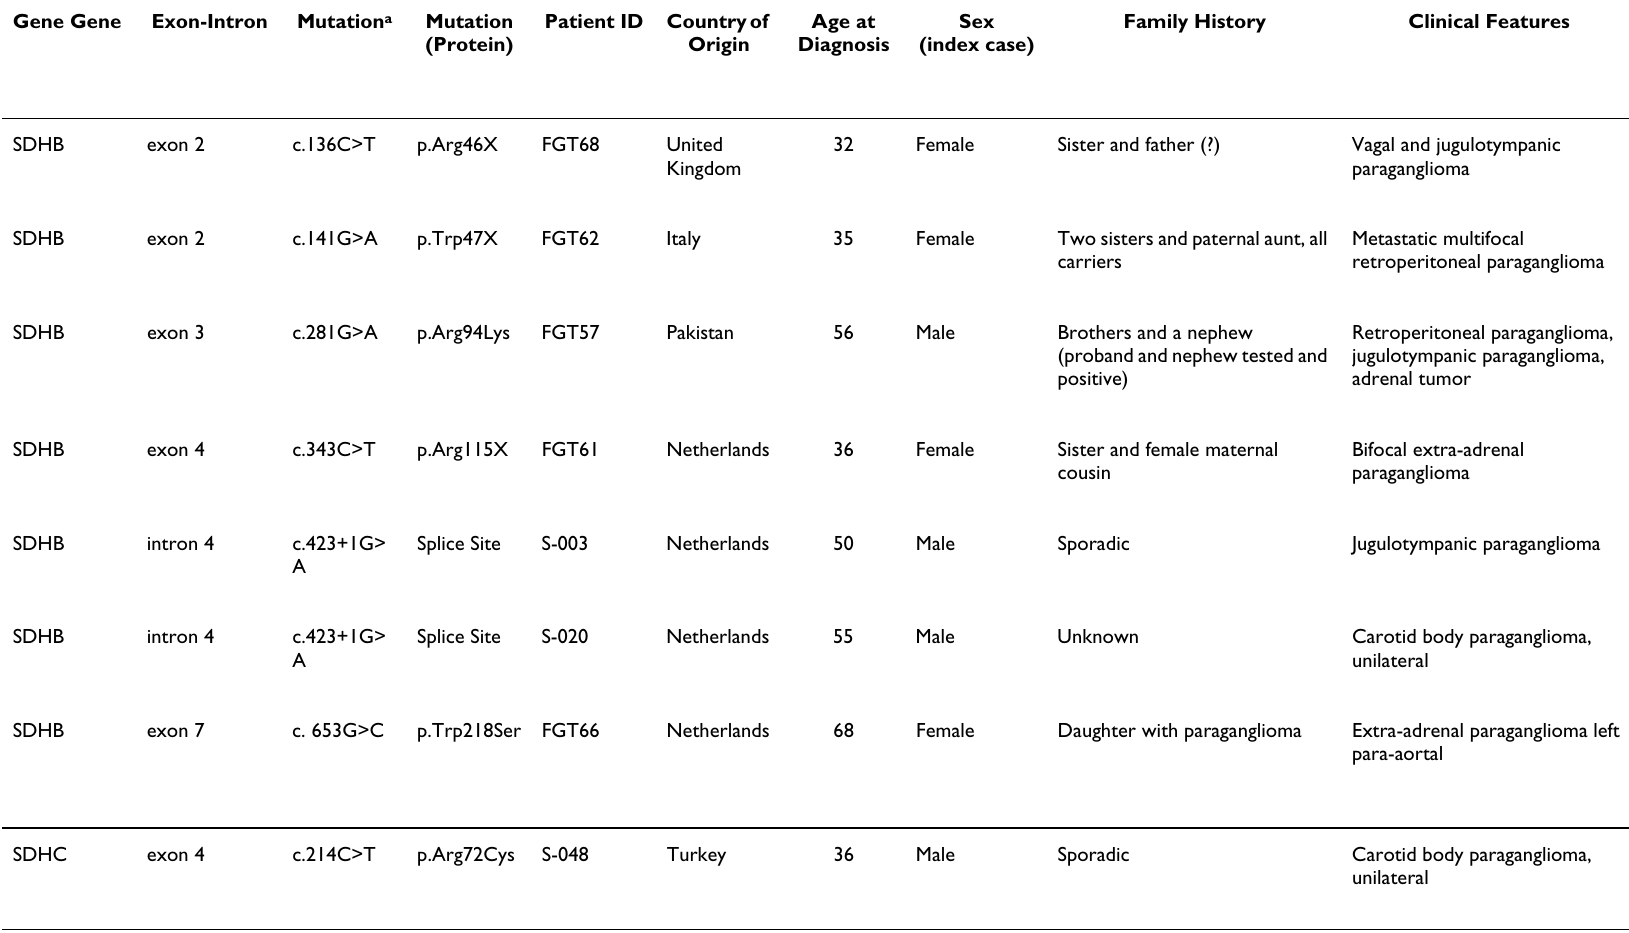
Table 2: Mutations of SDHB and SDHC found in this